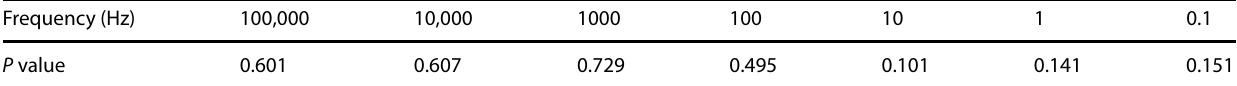
Table 1 Results from 2-sample t test performed on normalized impedance magnitude ( Z ) data from 36 h trial Frequency